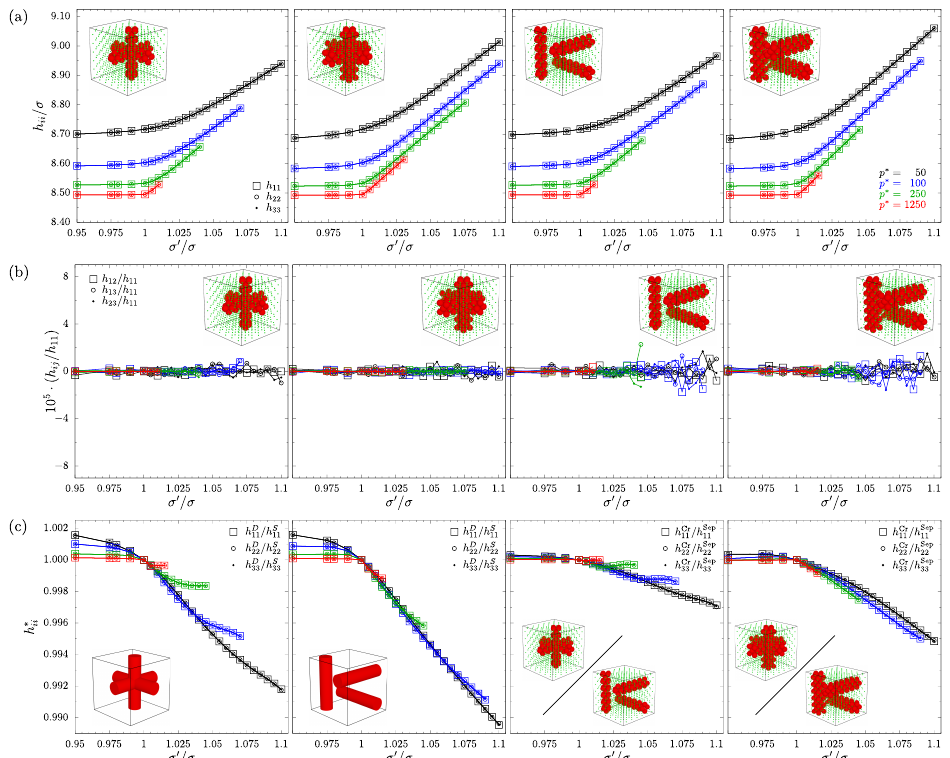
Figure 4. Box matrix components h ij for all the systems studied, plotted with respect to the scaling factor σ (cid:48) / σ (row a ), off-diagonal components divided by h 11 (row b ). Row ( c ) presents the ratios of = h X the diagonal components of the box matrix h ∗ / h Y from the left: X , Y are D -type and S -type, ii ii ii respectively, for (i) crossing “Cr” and (ii) separate “Sep” nanochannels, and X , Y are crossing and separate nanochannels, respectively, for (iii) D -type and (iv) S -type systems. Data for different values of reduced external pressure p ∗ are colored. In the case of figures ( a , c ), the simulation errors of the values are below 0.1% and the are considerably smaller than the symbols representing them. In the case of figures ( b ), the zero value is within the error